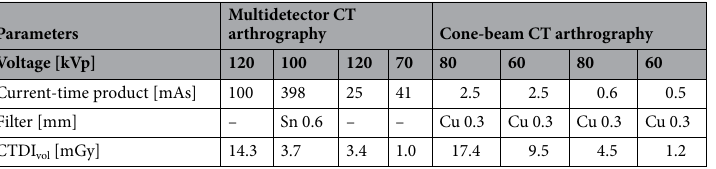
Table 1. Scan protocols. Scan protocols and radiation dose for multidetector and cone-beam CT arthrograms. Cu standard copper prefiltration, Sn tin prefiltration, CTDI vol volume computed tomography dose index for 16 cm